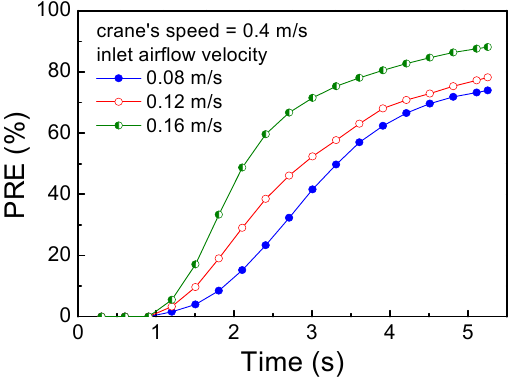
Figure 7. Variations in the particle removal efficiency (PRE) related to the time.